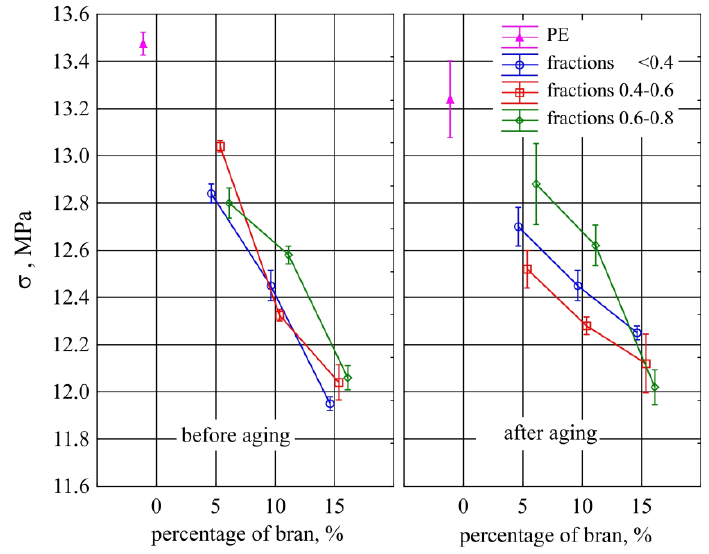
Figure 22. Tensile strength of injection mouldings before and after aging depending on the mass content and grain size of the introduced bran fraction (average values with standard deviation).